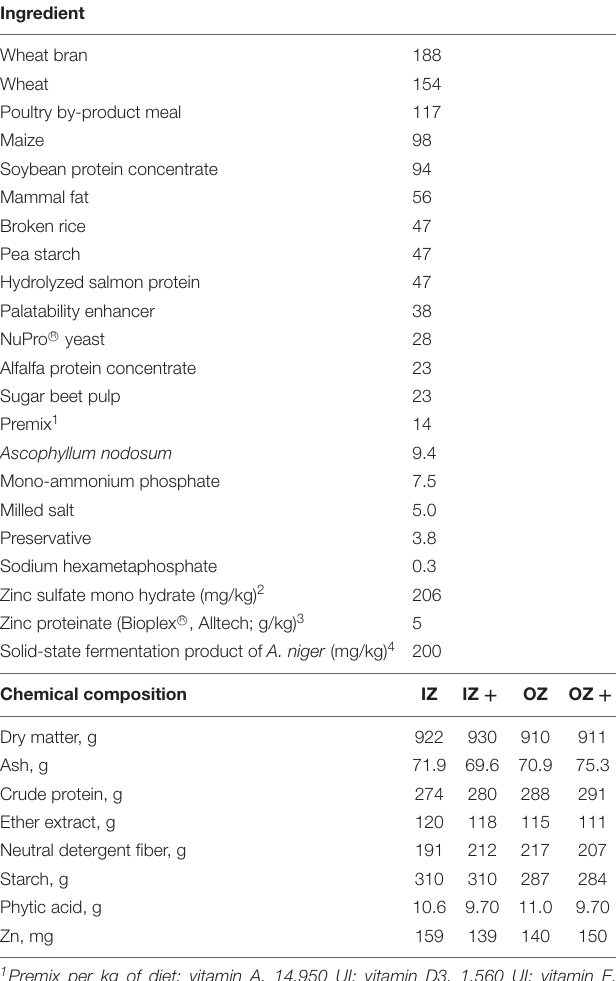
TABLE 1 | Ingredient list (g/kg, wet weight) and chemical composition (units/kg dry matter (DM)) of the experimental diets supplemented with inorganic (IZ and IZ + ) and organic (OZ and OZ + ) zinc sources without (IZ and OZ) and with (IZ + and OZ + ) the addition of a multi-enzymatic complex from the solid-state fermentation of Aspergillus niger